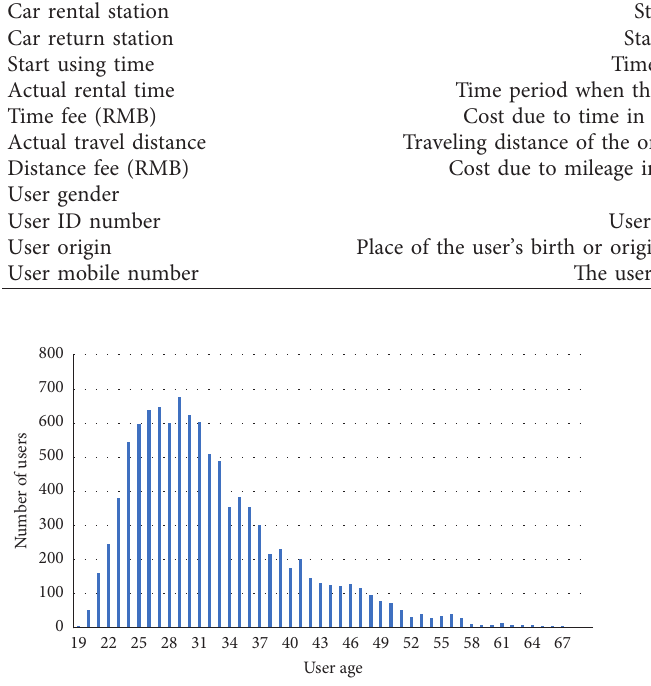
Figure 1: User age distribution